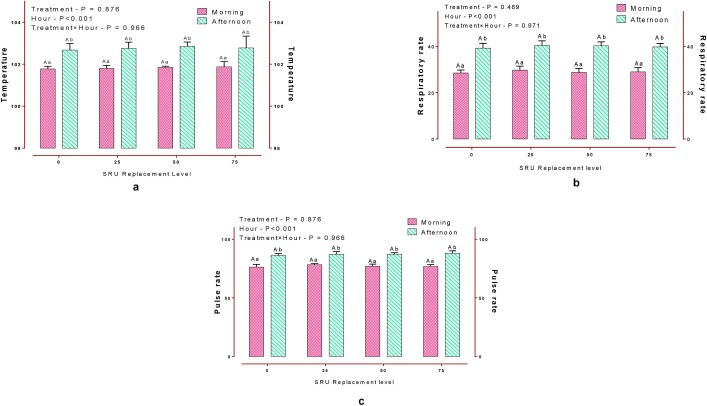
a, b, c Temperature, Respiratory rate, and Pulse rate in sheep during the two periods (Morning Vs. Afternoon). Means bearing different superscripts (A,B) differ significantly (P>0.05) within the same group at different periods and (a, b) between groups in same (P<0.01) period.